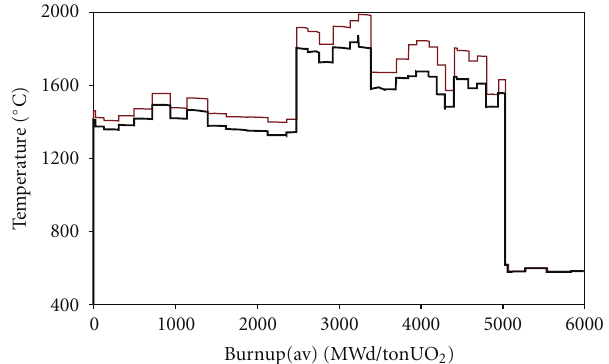
Figure 6: Pellet centre temperature during the previous irradiation. Standard (thick line) and maximum gap situation (thin line).